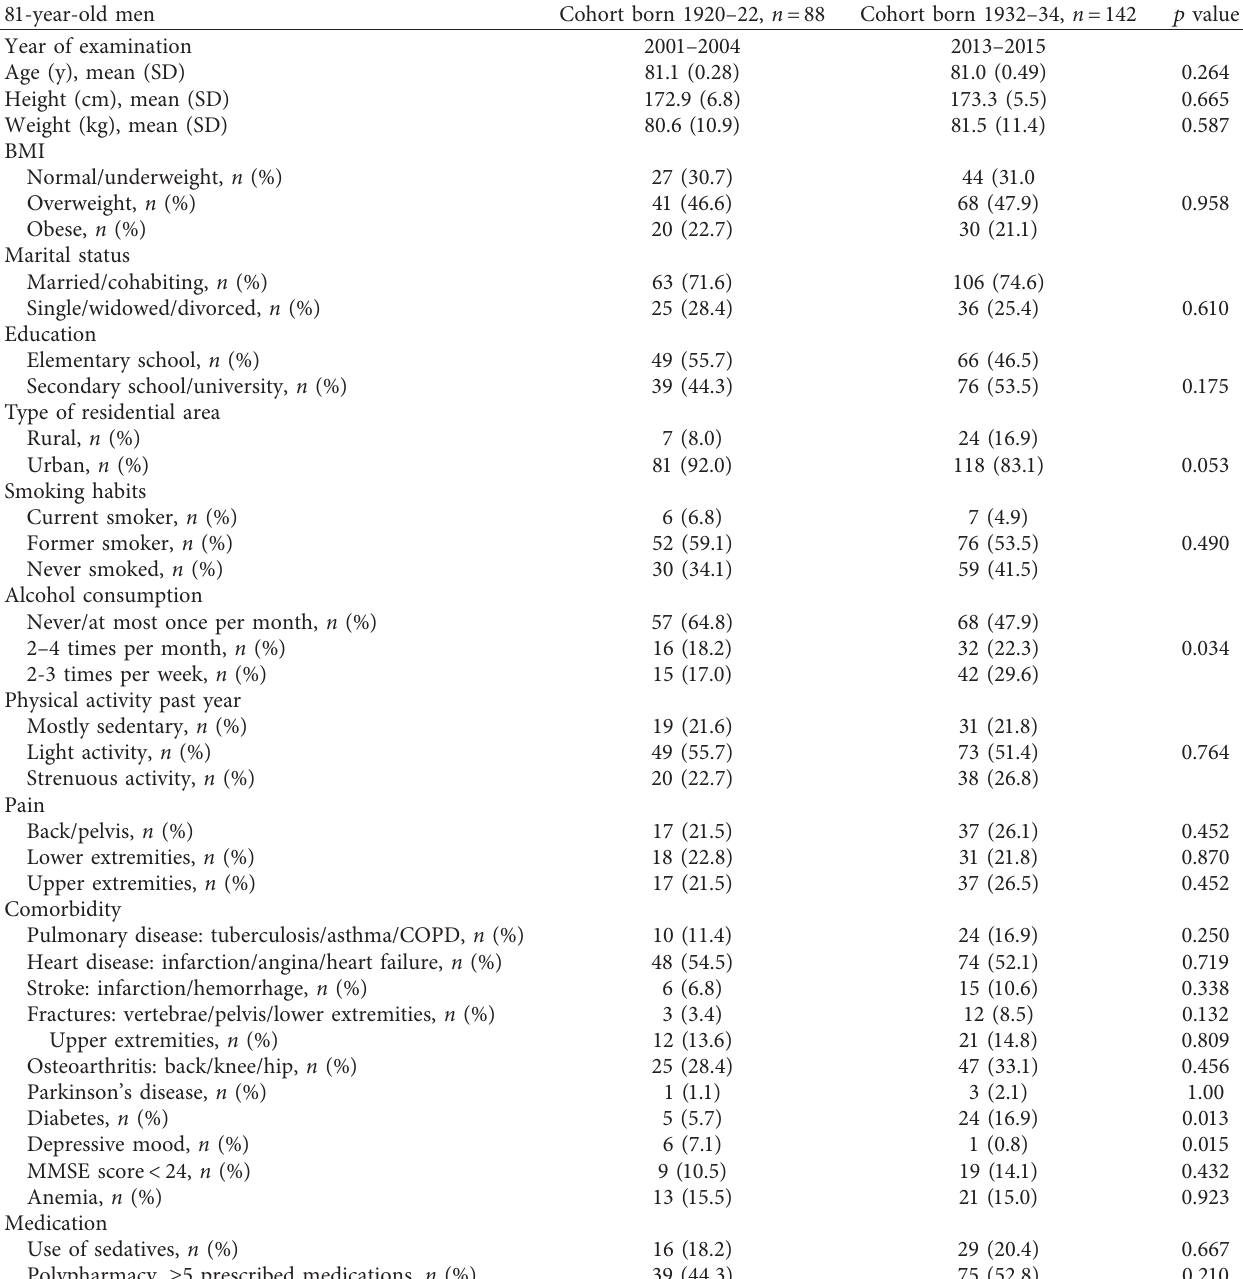
Table 1: Description of the 81-year-old men in the birth cohorts 1920–22 and 1932–34 from the Good Aging in Sk˚ane general population